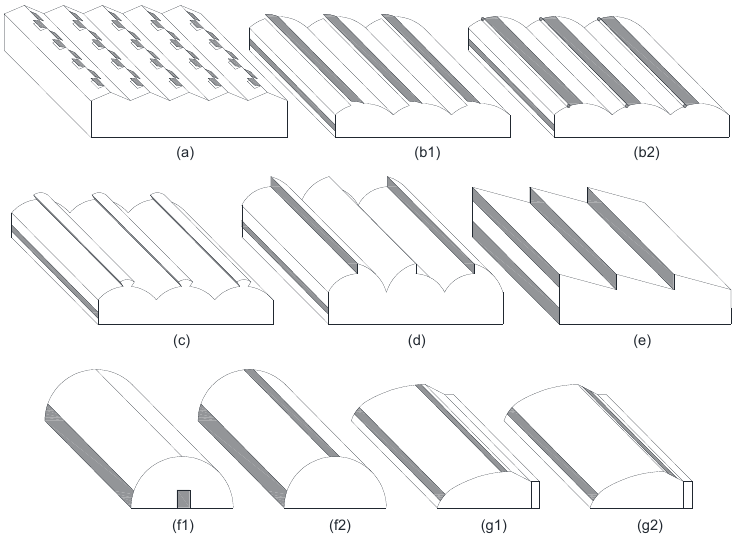
Figure 1. The structures of mixing ventilation ( a ), ( b1 , b2 , e ) with closed side wall vents, cross-ventilation ( f1 ), ( b1 – e ) with closed roof vents, and displacement ventilation ( b1 – e , f2 – g2 ).